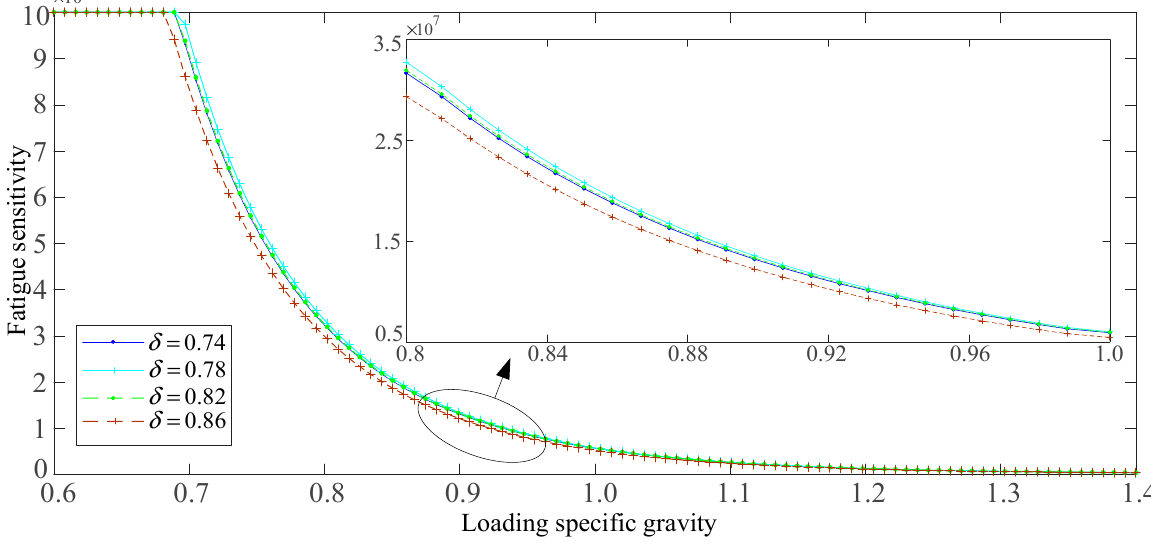
Figure 22. Effect of loading specific gravity on fatigue characteristics of flexible wheels with different wall thickness.